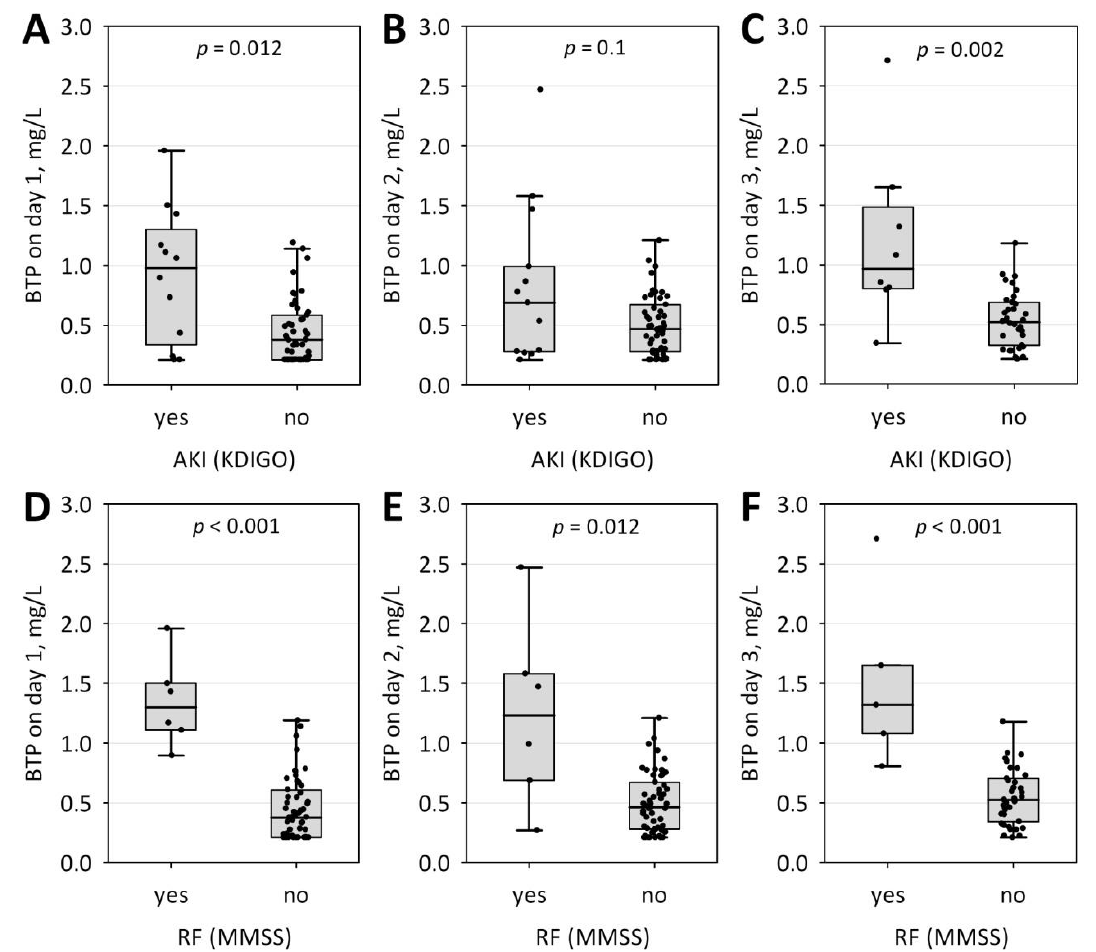
Figure 1. Serum beta-trace protein (BTP) concentrations on day 1 ( A , D ), 2 ( B , E ) and 3 ( C , F ) of hospital stay among patients with AP complicated with acute kidney injury (AKI) diagnosed according to Kidney Disease Improving Global Outcomes (KDIGO) guidelines ( A – C ) or renal failure (RF) diagnosed according to modified Marshall scoring system (MMSS) ( D – F ) versus patients without these complications. Data are shown as raw data (points), median (central line), interquartile range (box), and non-outlier range (whiskers).